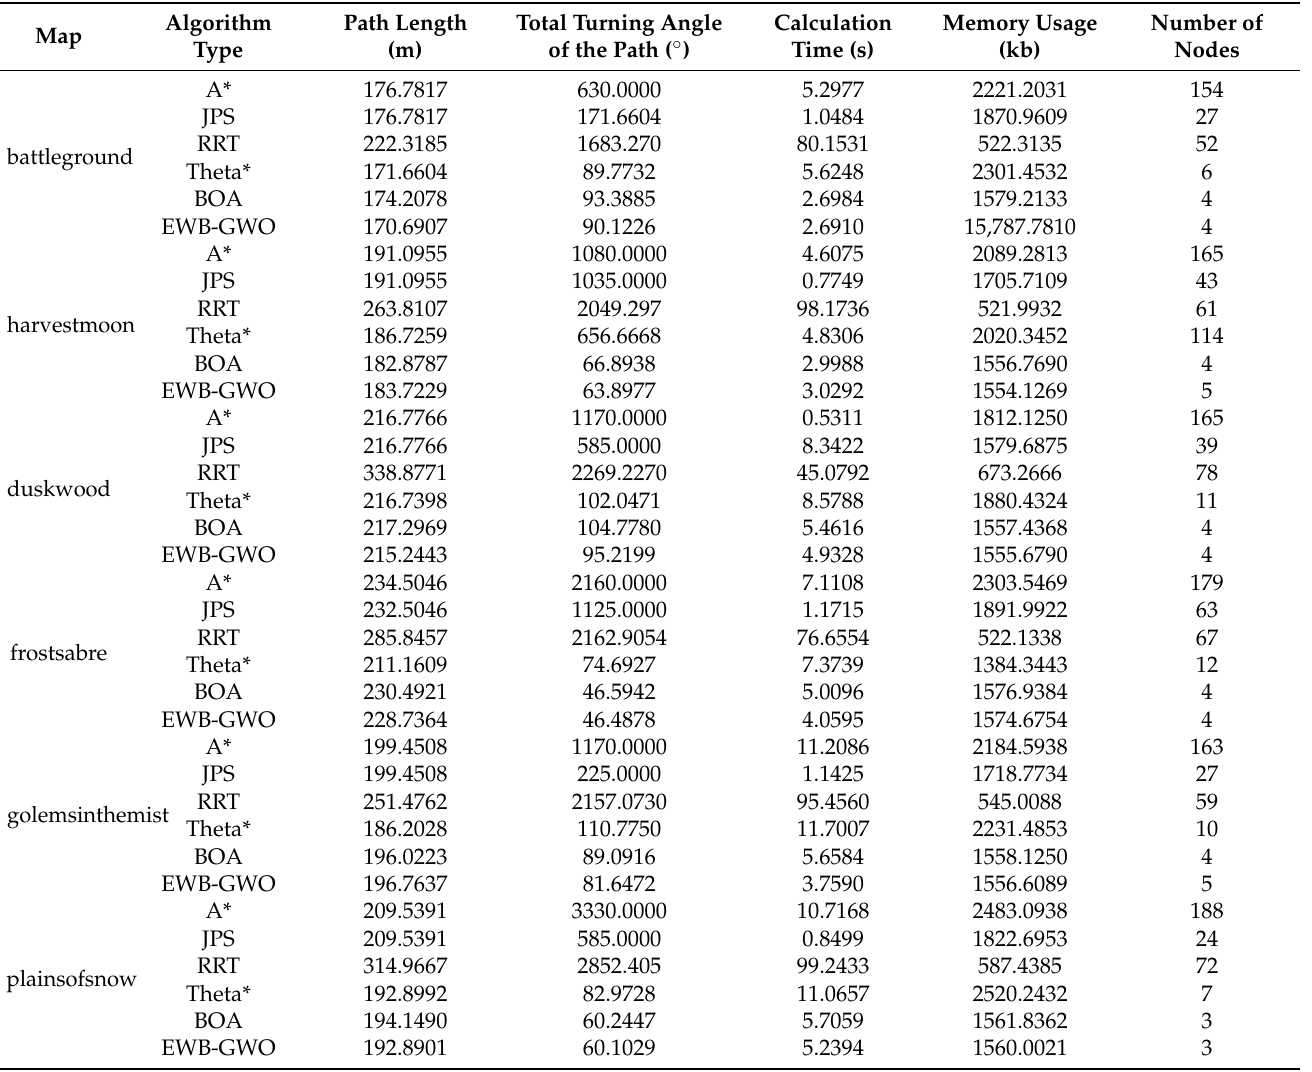
Table 12. Experimental results of path planning under game